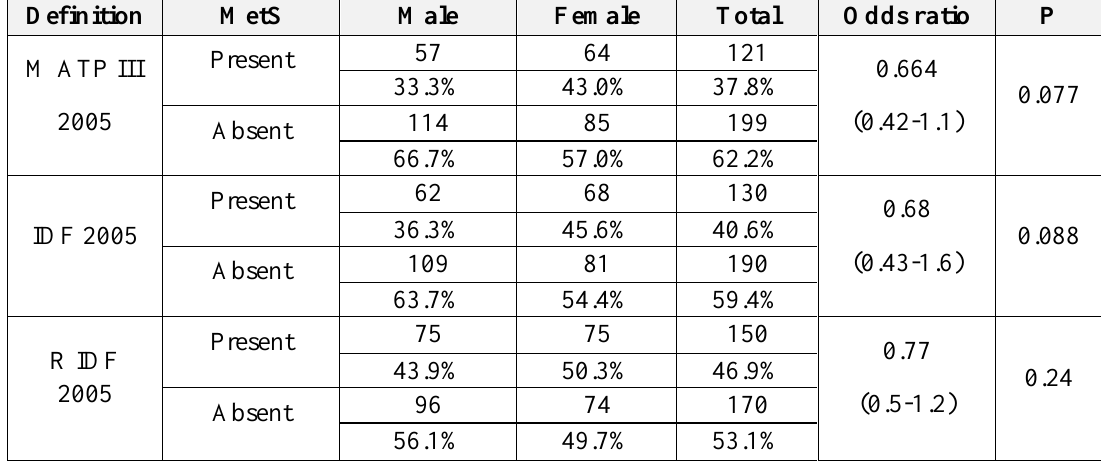
Table (4): Prevalence of metabolic syndrome according to the three definition protocols among study population by gender.